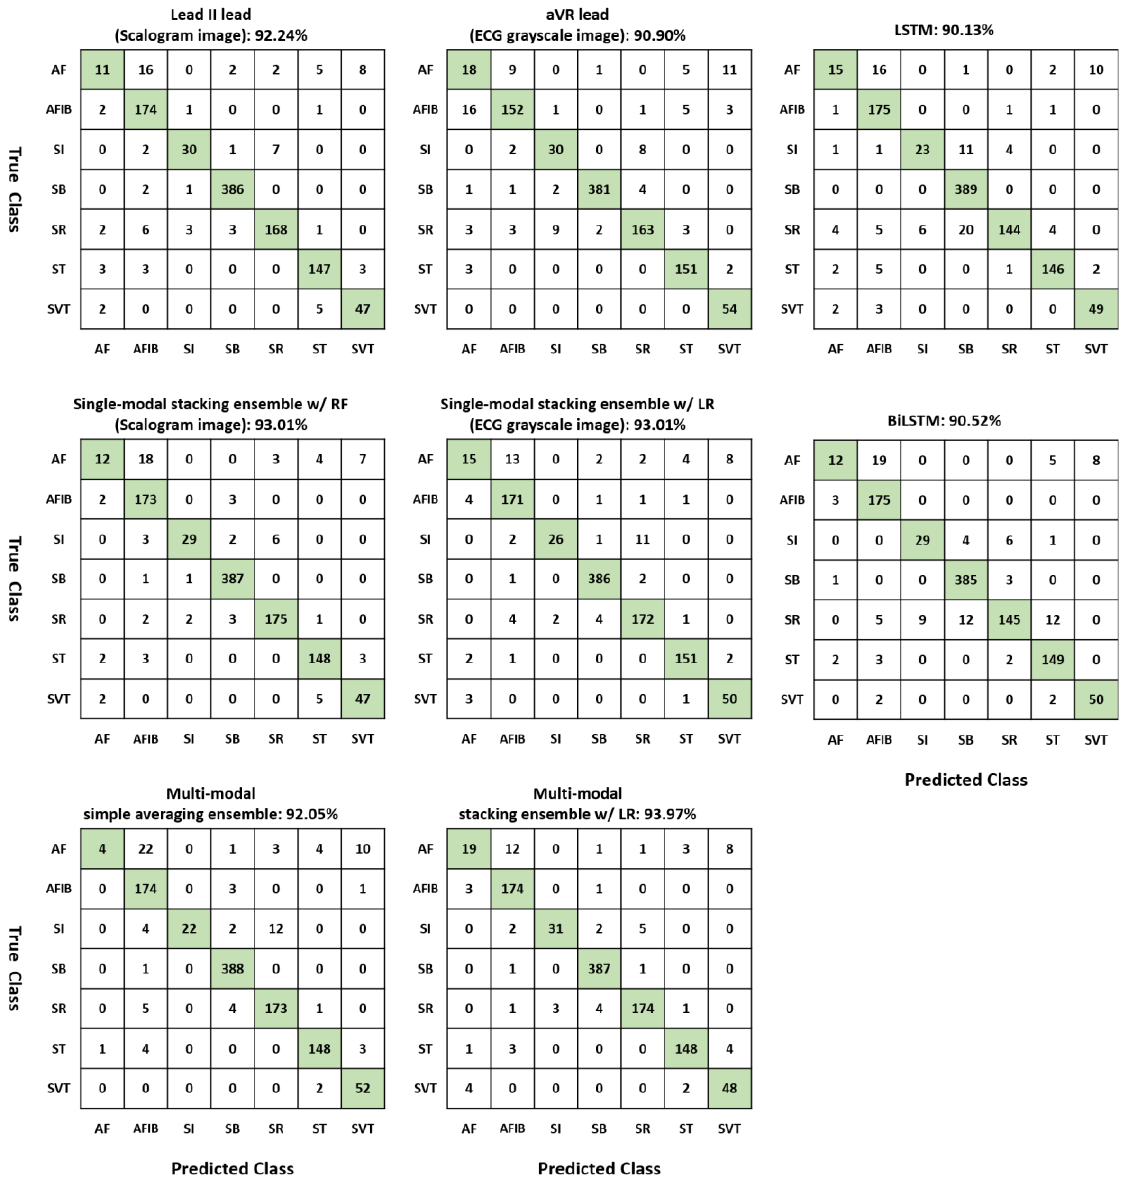
Figure 4. Confusion matrices of two single leads (Lead II lead for scalogram image and aVR lead for ECG grayscale image), LSTM, BiLSTM, a single-modal stacking ensemble with random forest (RF) for scalogram images, a single-modal stacking ensemble with logistic regression (LR) for ECG grayscale images, multi-modal simple averaging ensemble, and a multi-modal stacking ensemble with logistic regression.